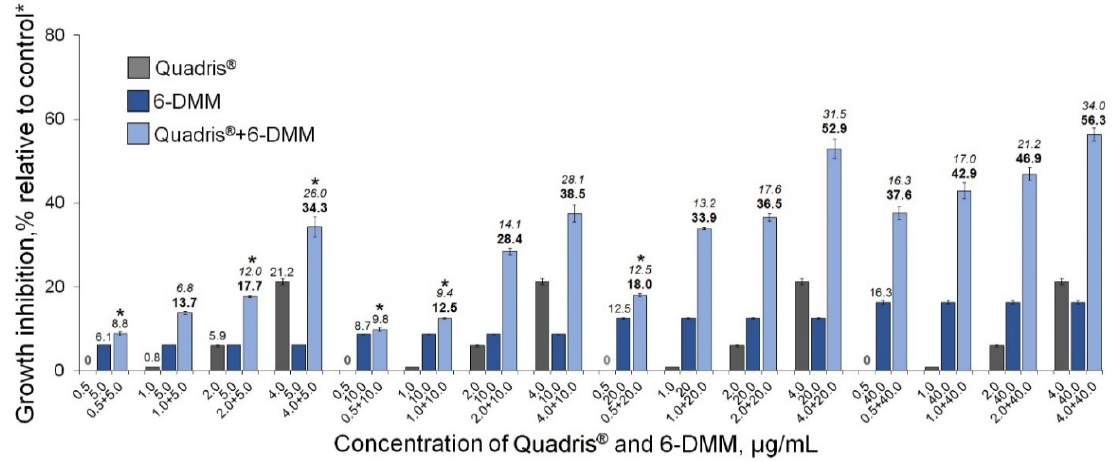
Figure 6. The inhibitory effect of Quadris ® SC 250 on the in vitro growth of Rhizoctonia solani augmented due the fungicide combination with 6-DMM. Each bar represents the mean of three experiments. Concentration combinations providing an additive effect are marked with asterisks; for other combinations, E r > E e at p ≤ 0.05 (see Materials and Methods 4.4). The difference between treatments is significant at p ≤ 0.05 ( t -test for independent variables). * Control colonies were cultured on potato dextrose agar free of 6-DMM and the fungicide.